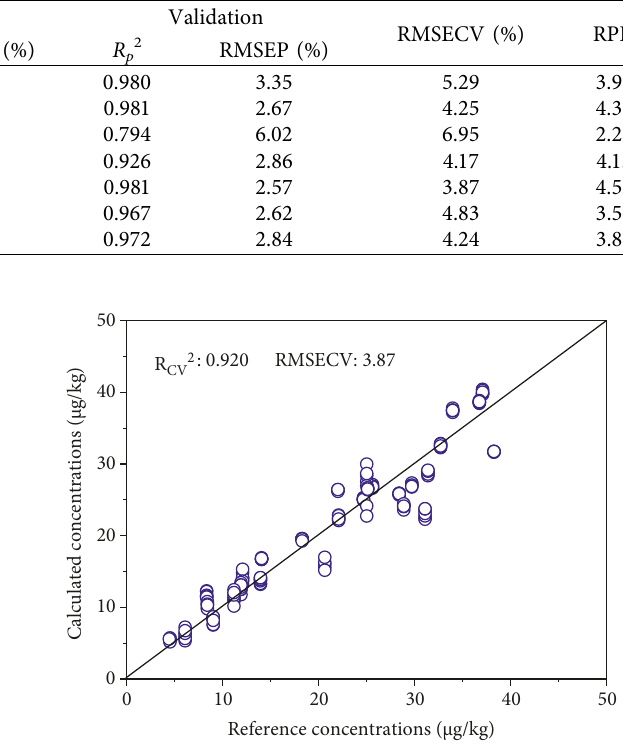
Figure 10: Results of internal cross-validation of the quantitative model.